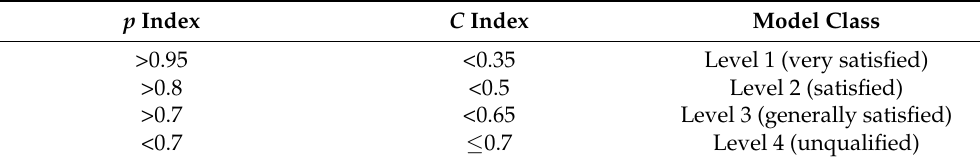
Table 4. Posterior error test table.